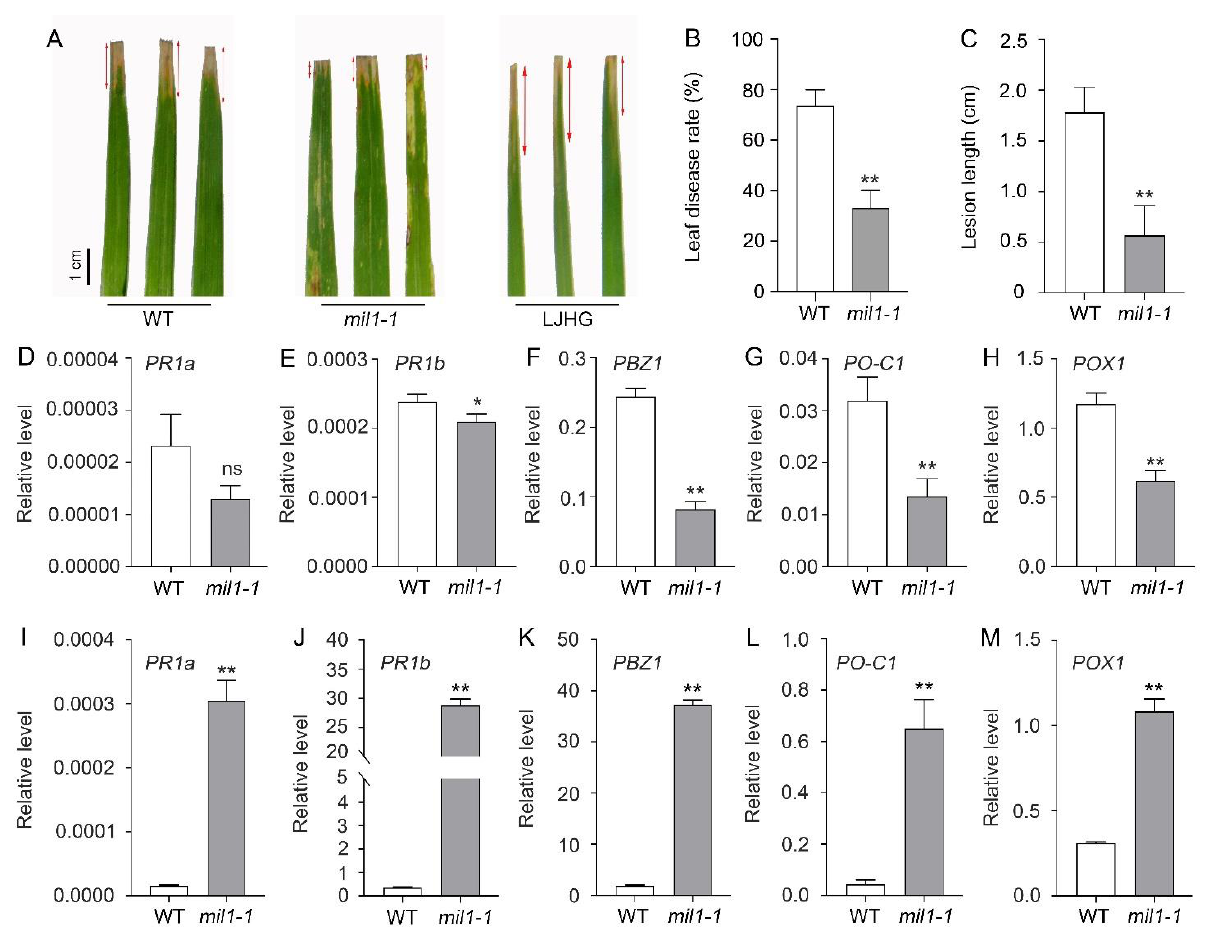
Figure 5. Mutation of MIL1 enhances the resistance to bacterial blight in rice. ( A ) Phenotypes of WT and mil1-1 inoculated with isolate of bacterial blight Zhe173. ( B ) Leaf disease rate of WT and mil1-1 after inoculation. ( C ) Lesion length of WT and mil1-1 after inoculation. ( D – H ) The expression of defense response genes detected by RT-qPCR before lesion formation, including PR1a ( D ), PR1b ( E ), PBZ1/PR10 ( F ), PO-C1 ( G ), and POX1 ( H ). ( I – M ) The expression of defense response genes detected by RT-qPCR after lesion formation, including PR1a ( I ), PR1b ( J ), PBZ1/PR10 ( K ), PO-C1 ( L ), and POX1 ( M ). Rice ACTIN1 ( OsACT1 ) was used as an internal control. Data in ( B – M) are means ± SD. A two-tailed unpaired t -test with Welch’s correction is used for statistical analysis. Asterisks indicate significant differences between treatments and respective controls at each time point (* p < 0.05, ** p < 0.01; Student’s t test).